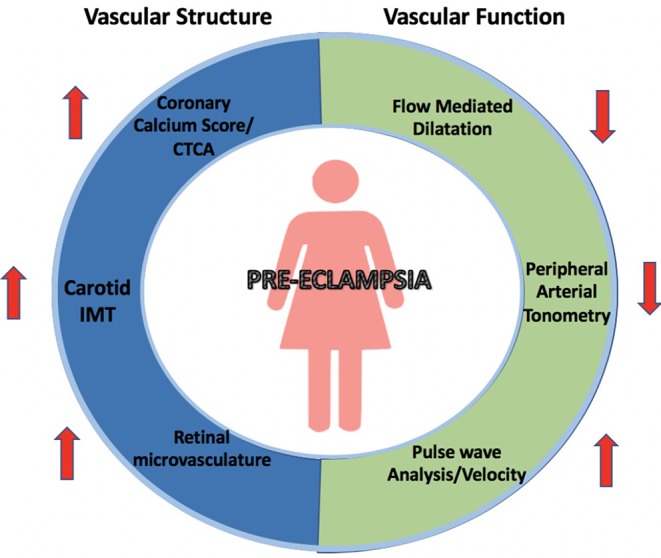
Changes in vascular structure and function associated with pre-eclampsia. Summary of measurements of vascular structural and functional changes illustrated by non-invasive modalities including coronary calcium scores and CT coronary angiograms, carotid IMT, retinal microvasculature, flow-mediated dilation, peripheral arterial tonometry and pulse wave velocity and analysis.